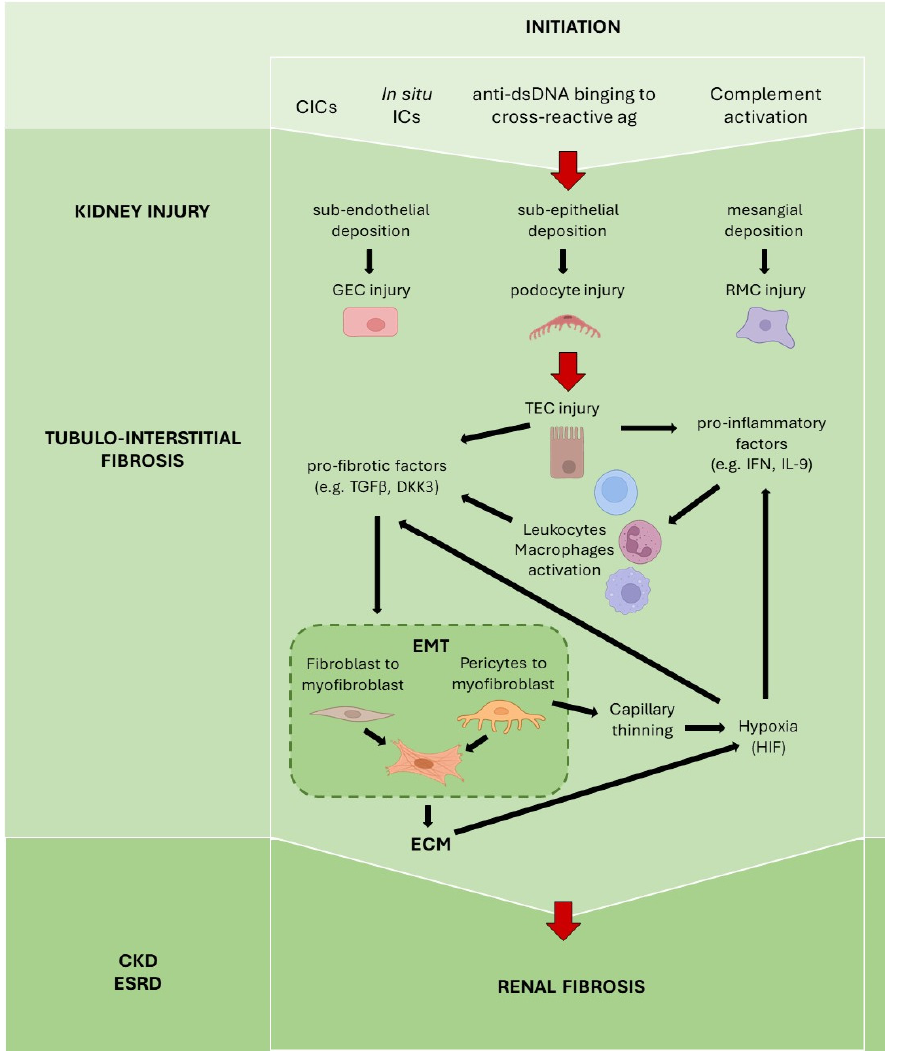
Figure 2. Main mechanisms involved in the pathogenesis of renal fibrosis in LN. Abbreviations: